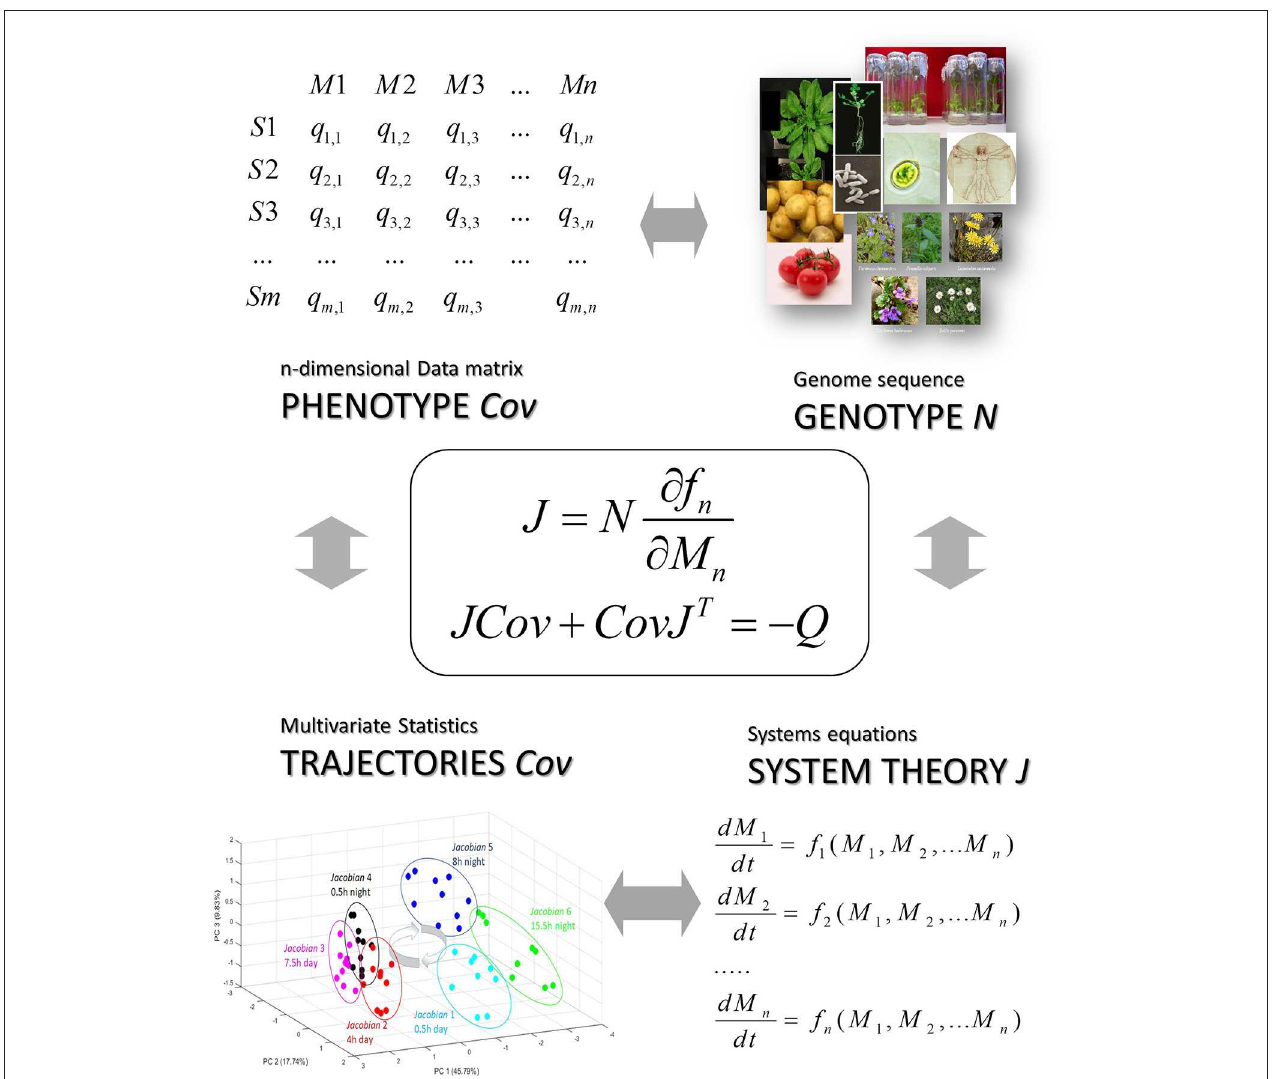
FIGURE 5 | The stochastic Lyapunov matrix equation presents a genotype-phenotype equation. Here N is the metabolic interaction matrix or stoichiometric matrix which is derived from a whole-genome metabolic reconstruction (see also Figure 1 and [12]), Cov is defined by the data matrix and the systems equation are represented by the Jacobian which is the linearized solution of this non-linear system at a quasi-equilibrium point and reflected by the time-dependent trajectory of the system (see Figure 3 ) (for more details see